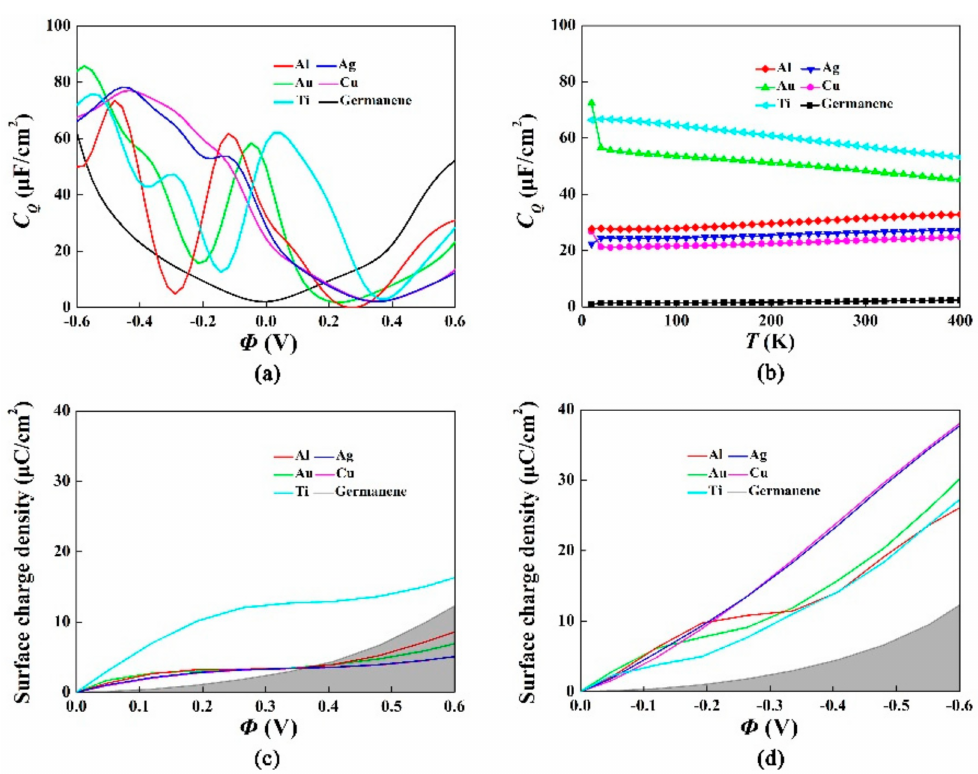
Figure 4. ( a ) Quantum capacitance of the pristine germanene adsorbed Ti, Au, Ag, Cu, Al at the most stable configuration; ( b ) Change of C Q with temperature in the scope of 0 K–400 K, the consequences gained in 4 × 4 supercell at a doping concentration of 9.4%; ( c , d ) Surface charge density vs. Φ between − 0.6 V and 0.6